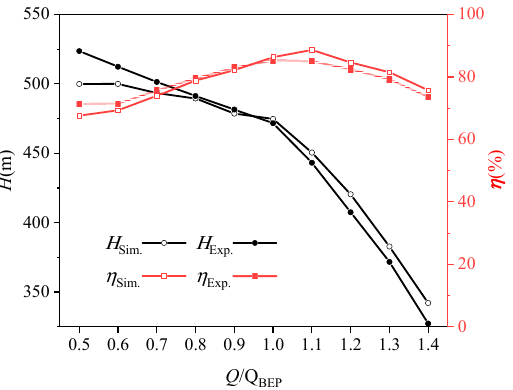
Figure 4. Validation of the external characteristics at 132.72 mm guide vane opening.